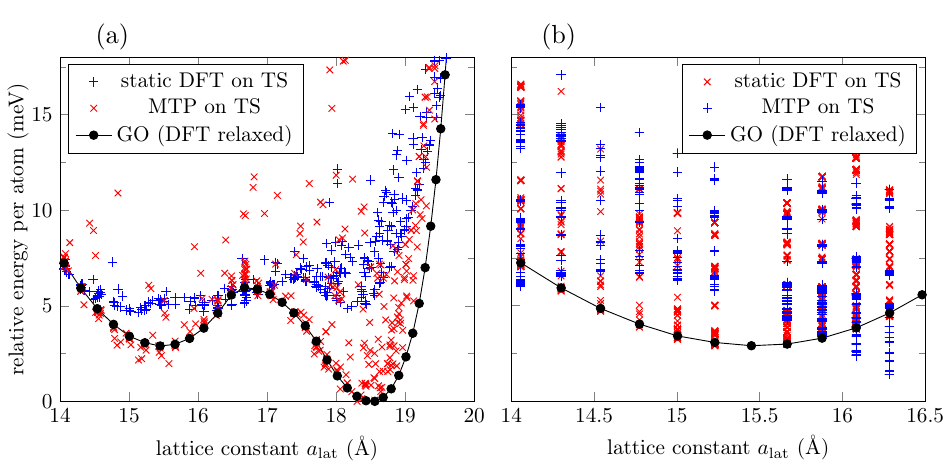
Figure 5. ( a ) Energy distribution of the TS for a model trained using a cutoff of 10Å, according to DFT and MTP. ( b ) Energy distribution of the TS for a model trained on a restricted range of lattice constant values from 14Å to 16.5Å. For comparison, ground state energies, according to DFT calculations, are provided (black